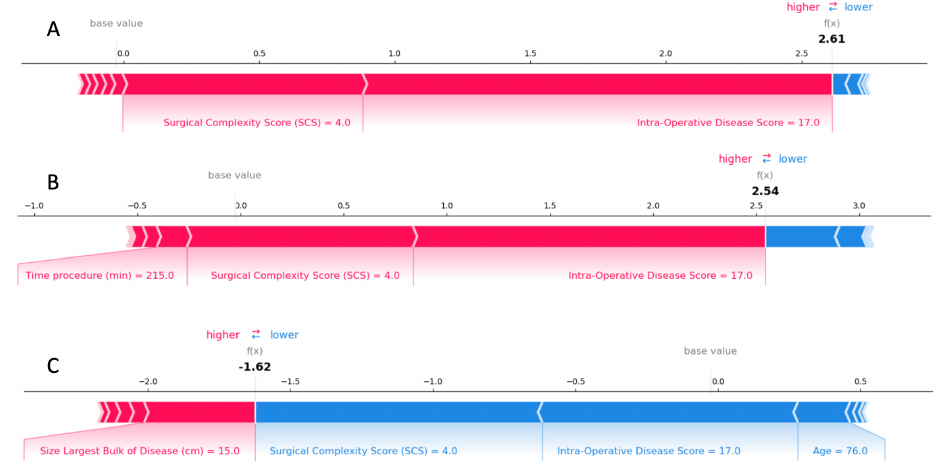
Figure 5. Examples of SHAP force plots illustrating the predicted explained risks for an individual patient. For the R0 resection risk, blue features have values that increased the risk, and red features decreased the risk. The combination of impacts of all features is the predicted R0 prediction